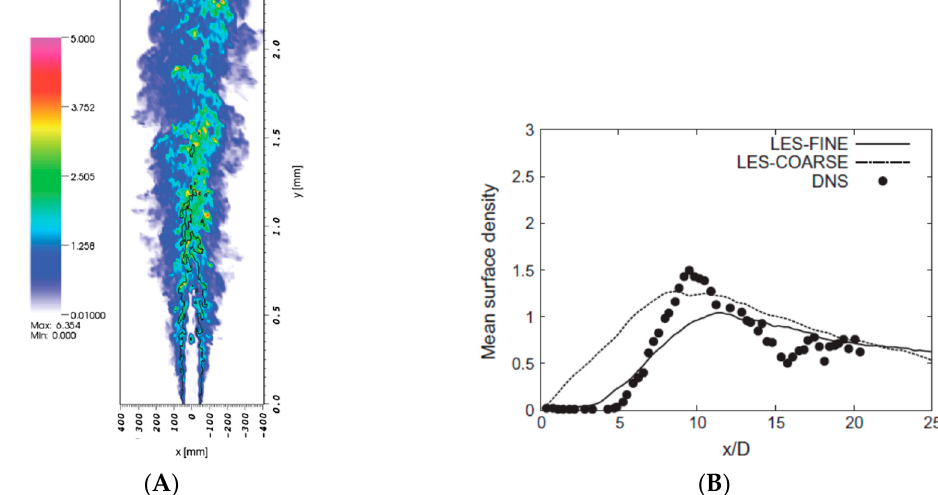
Figure 12. Result of spray simulation using the probability density function (PDF) method [60]. ( A ) Surface density field; ( B ) Surface density profiles along the injection axis. Reproduced with permission from Elsevier.